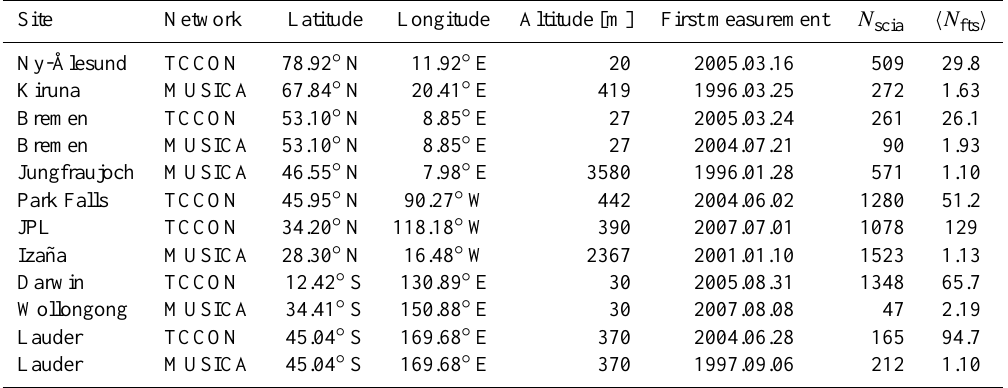
Table 1. Overview of the FTS stations used in the validation study for the period 2003–2007. N scia is the number of SCIAMACHY mea- surements which were co-located with at least one FTS measurement within a 500km radius and a 2h time window. (cid:104) N fts (cid:105) is the average number of FTS data points per co-located SCIAMACHY